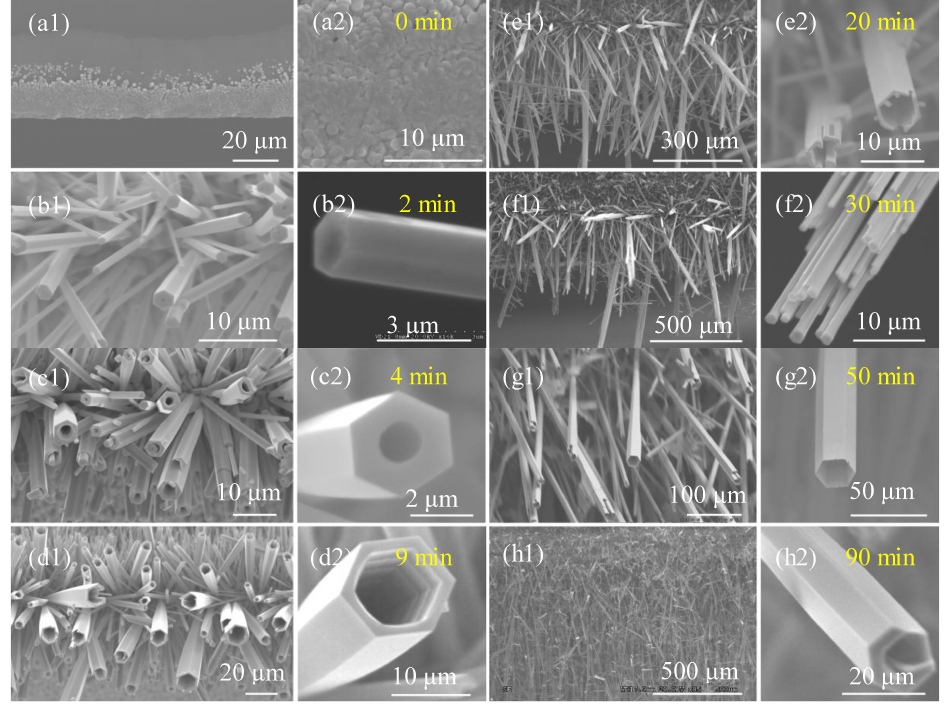
Figure 4. ZnO structures generated on sidewalls of Si blocks during four growth periods (SEM images): ( a ) preformed ZnO seeds; ( b ) MRs in Step I; ( c – d ) MTs in Step II; ( e – f ) MWs on the wall of MTs in Step III; and ( g – h ) long MTs in Step IV. The corresponding growth times are given in the corresponding images. ( a1 – h1 ) perspective and ( a2 – h2 ) close-up views of the ZnO